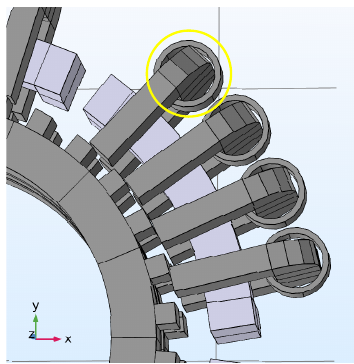
Figure 23. Modified 3D-FEM model.